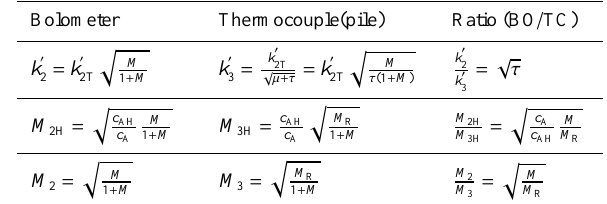
Table 2. Summary of the relations between the figures of merit quoted in Table 1 and the dimensionless figure of merit M and its radiative component M R .